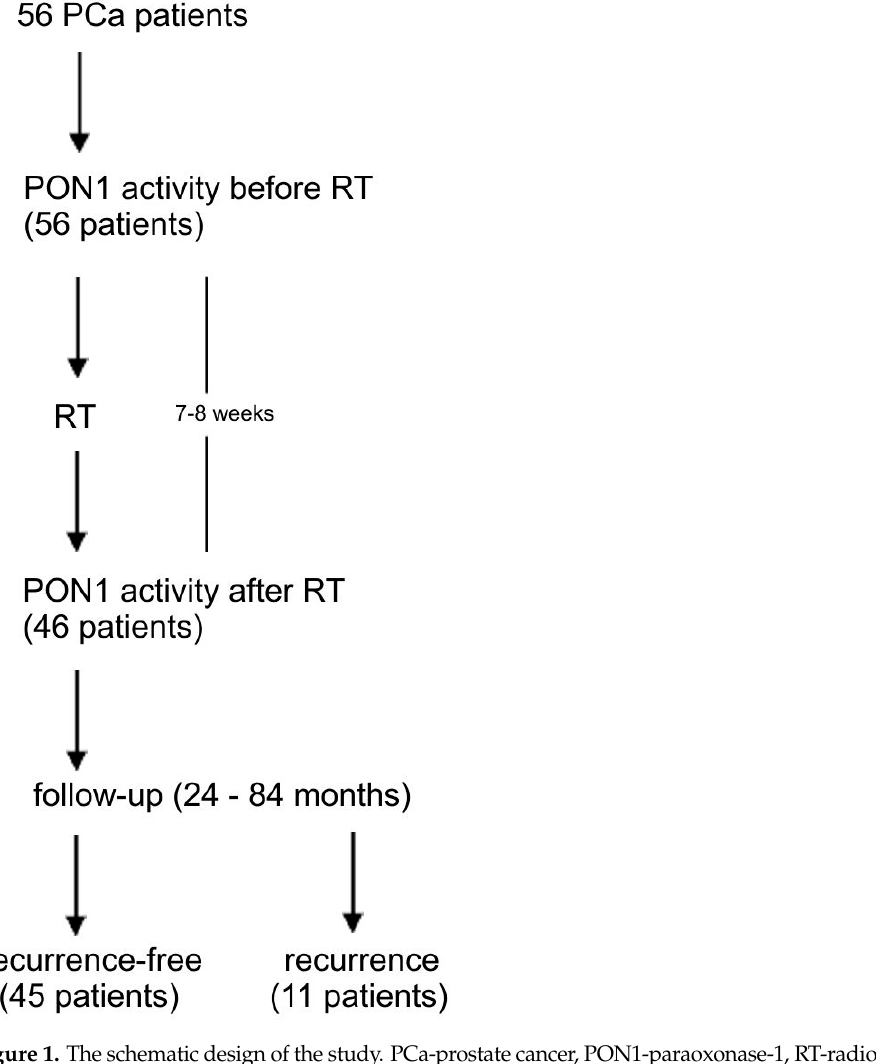
Figure 1. The schematic design of the study. PCa-prostate cancer, PON1-paraoxonase-1, RT-radiotherapy.